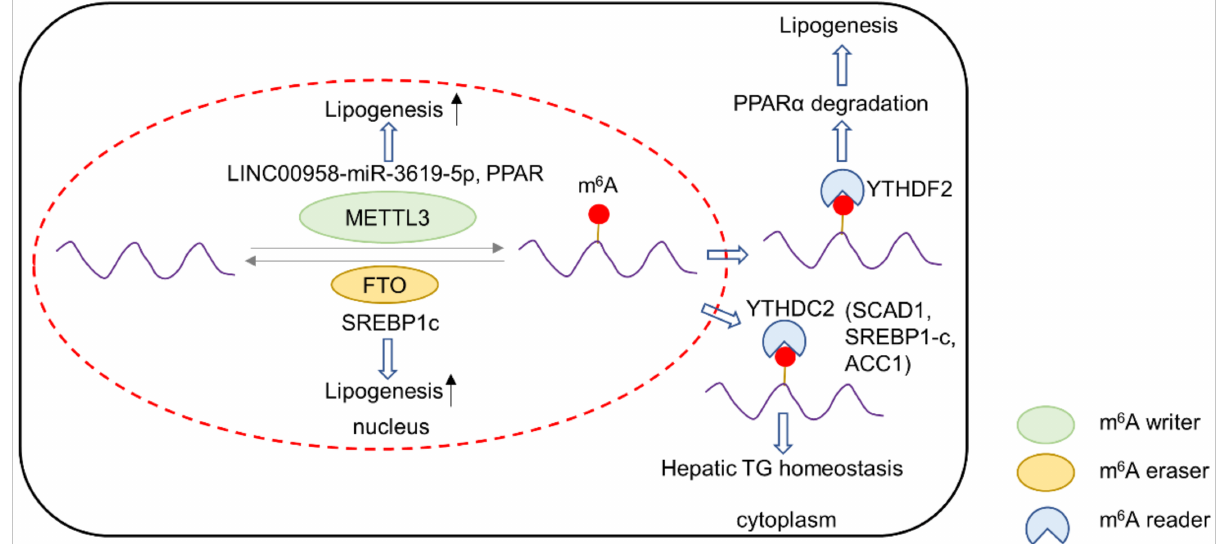
Figure 3. Schematic diagram summarizing the interplay between m 6 A regulators and lipid